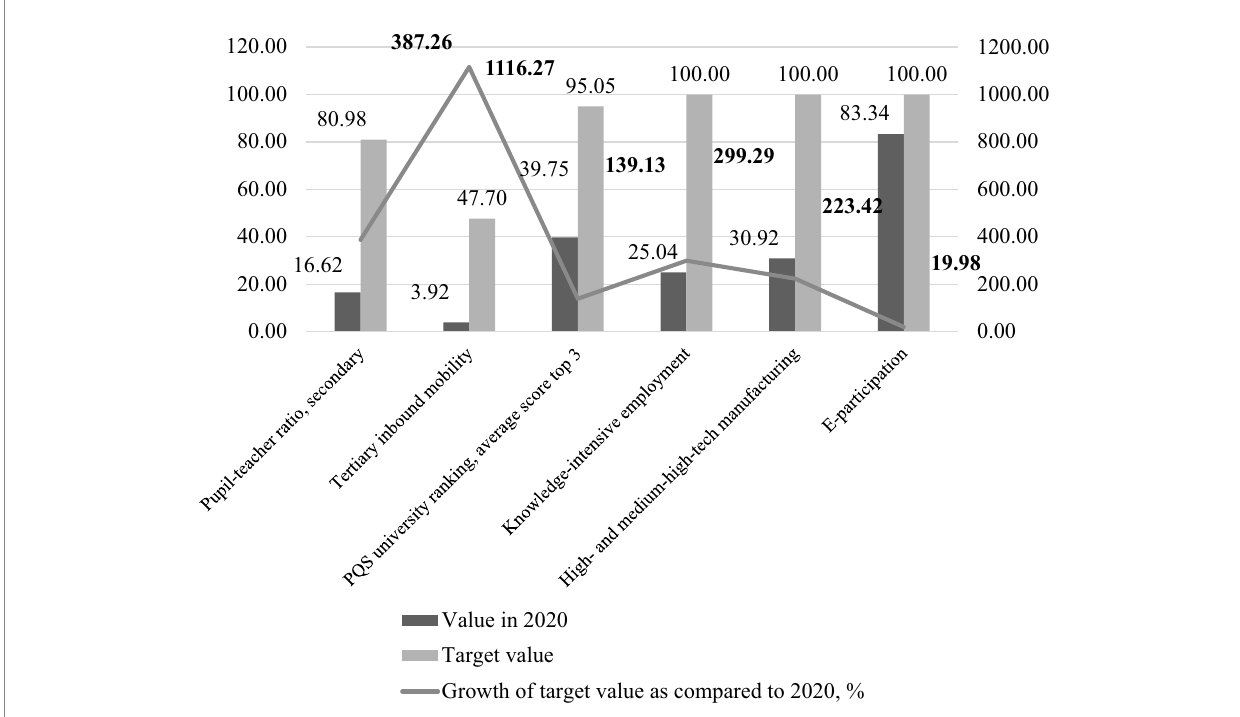
FIGURE 3 Perspectives of improving the implementation of the infrastructural role of education in the social and investment model of economic growth. Calculated and built by the